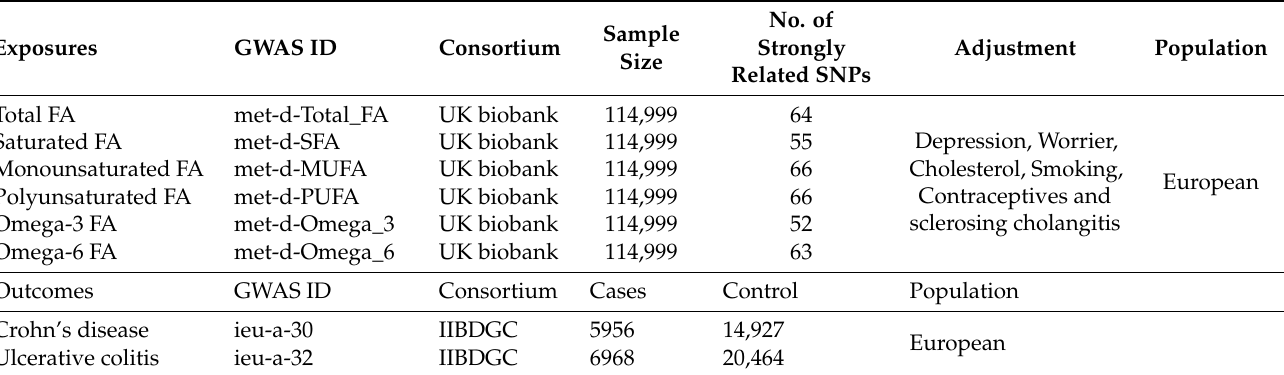
Table 1. The list of Genome-wide summary association studies (GWAs) included in the Mendelian randomization (MR) study.